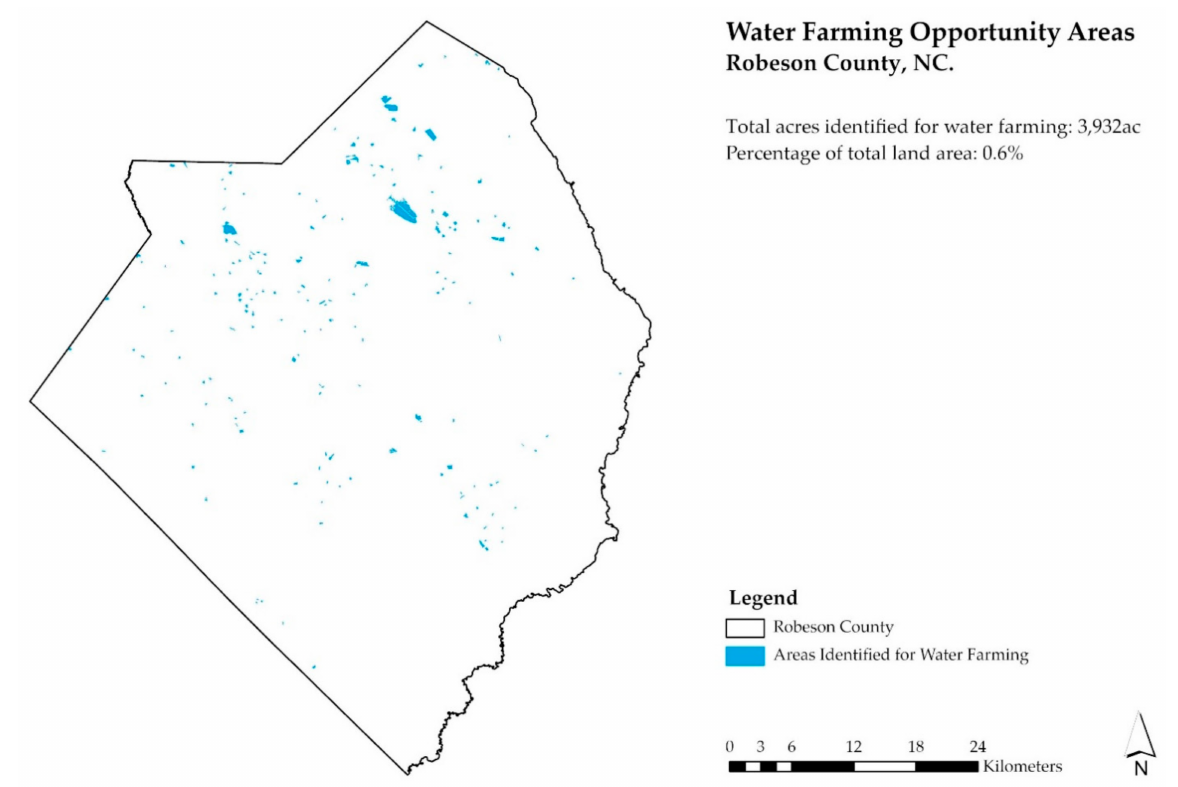
Figure 14. Dry dam and berm (water farming) opportunity areas in Robeson